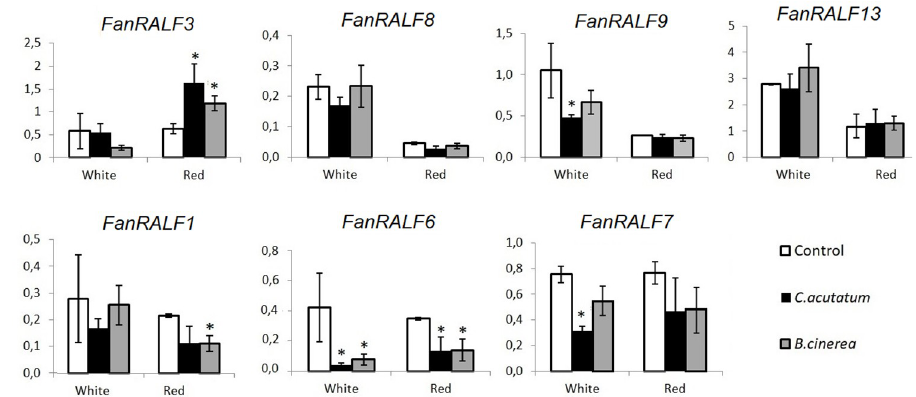
Fig 3. Expression of different RALF transcripts upon infection with pathogens. qRT-PCR analysis of different RALF genes (at the top the RALF-like 33 genes FanRALF3 , FanRALF9 , FanRALF8 and FanRALF13 ) in Fxa strawberry fruits at different ripening stages (white and red) 24 h post infection with C . acutatum and B . cinerea . Histogram bars represent three biological replicates average relative expression and black lines represents standard deviations. Student’s T test was used to calculate statistical significance between infected and control samples p < 0.05 ( � ).